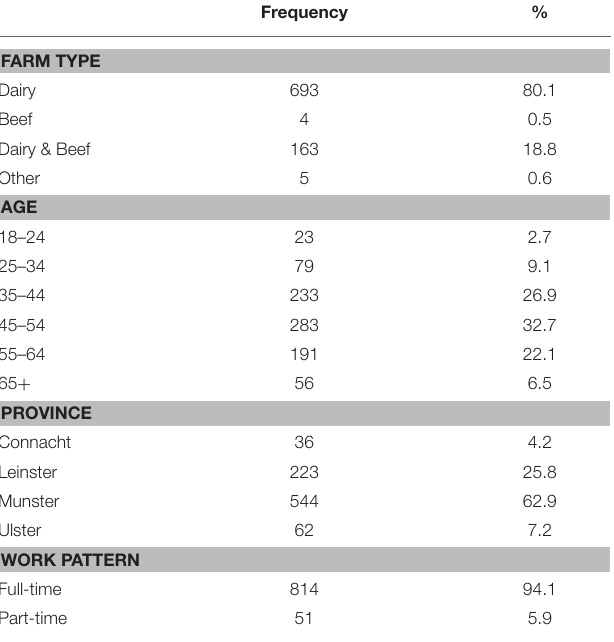
TABLE 1 | Demographic